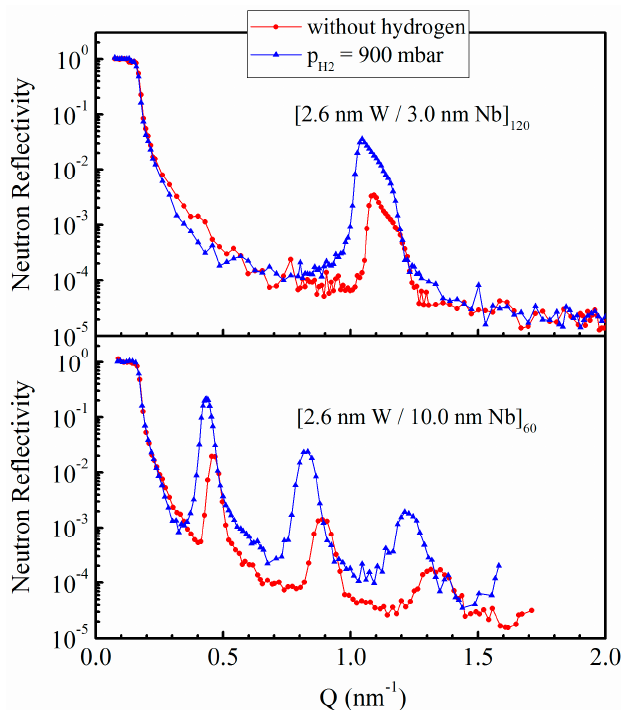
Figure 9. Neutron reflectivity curves of W/Nb multilayers with different Nb layer thicknesses as indicated, measured in the as ‐ prepared state (red circles), and at a hydrogen pressure of 900 mbar (blue triangles).